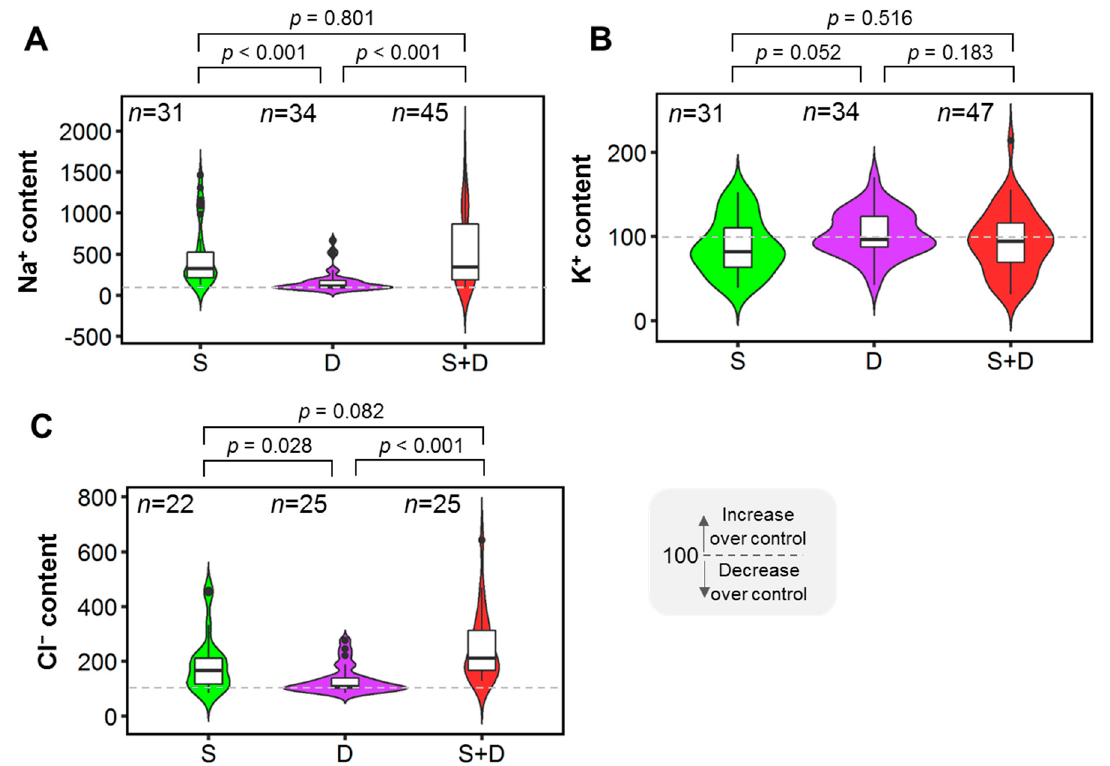
Figure 4. Effects of salinity (S), drought (D), and combined salinity and drought (S+D) stress on ionic homeostasis. ( A ) Na + content, ( B ) K + content, and ( C ) Cl − content. The % of control treatment is presented in the figures. The statistical differences were assessed using Welch’s t -test where the p value indicates the level of statistical difference, and a p value less than 0.05 was considered statistically significant. n indicates the number of